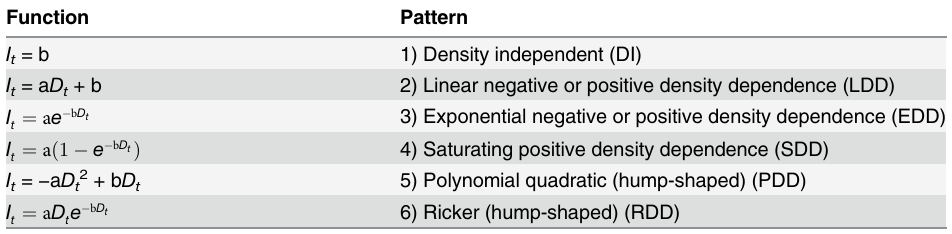
Table 1. Alternative functions fit to the data relating immigration ( I t ) to the number of damselfish remaining on the site ( D t ) following each removal event (t), where a and b are estimated parameters. For per site scaling, I t equaled the total number of immigrants arriving on the site between the removal and the subsequent count. For per new vacancy scaling, I t equaled the total number of immigrants arriving on the site between the removal and subsequent count divided by the number of damselfish removed. For per capita scaling, I t equaled the total number of immigrants arriving on the site between the removal and the subse- quent count divided by the number of damselfish remaining immediately after the removal. Function